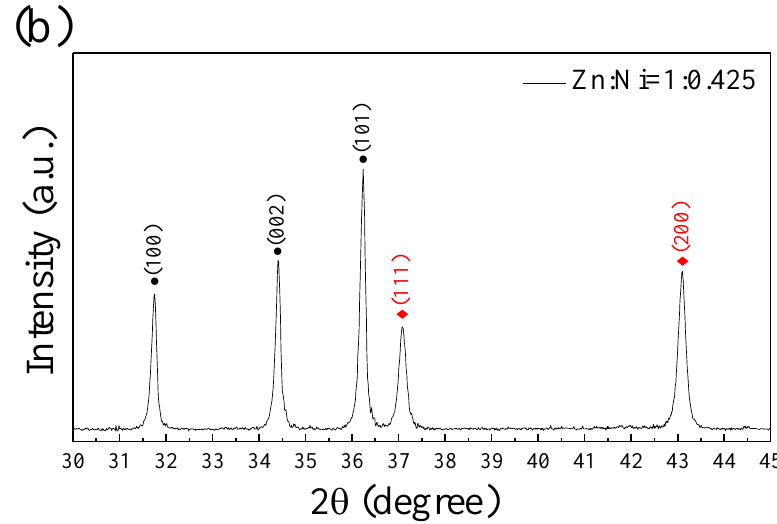
Figure 2. ( a ) XRD patterns of pristine ZnO and ZnO– x NiO composites annealed at 550 °C with different molar ratios of Zn:Ni. ( b ) Partially enlarged XRD patterns of ZnO–0.425NiO composite annealed at 550 °C.